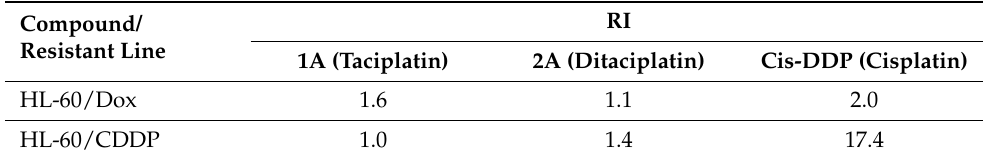
Table 3. Resistance Index (RI) determined for 1A , 2A , and the reference antineoplastic drug cisplatin in chemoresistant strains HL-60/Dox and HL-60/CDDP.